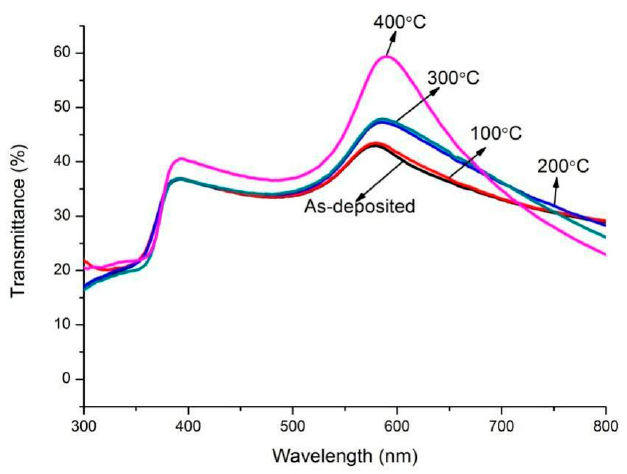
Figure 5. Optical transmission spectra of the ZnO(Cu) film system with varying annealing temperatures.